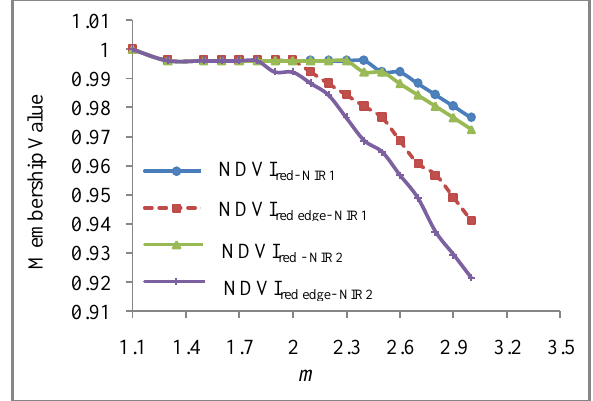
Figure 2: Flow chart for the methodology